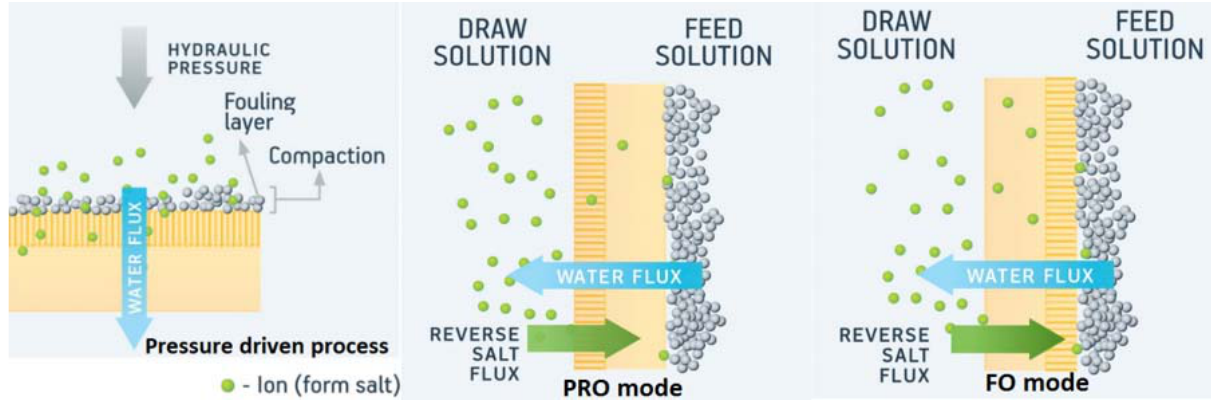
Figure 4. Illustration of the fouling mechanisms in membrane processes a) fouling in RO and osmotically driven membrane processes (b) fouling in PRO mode; (c) fouling in FO mode.